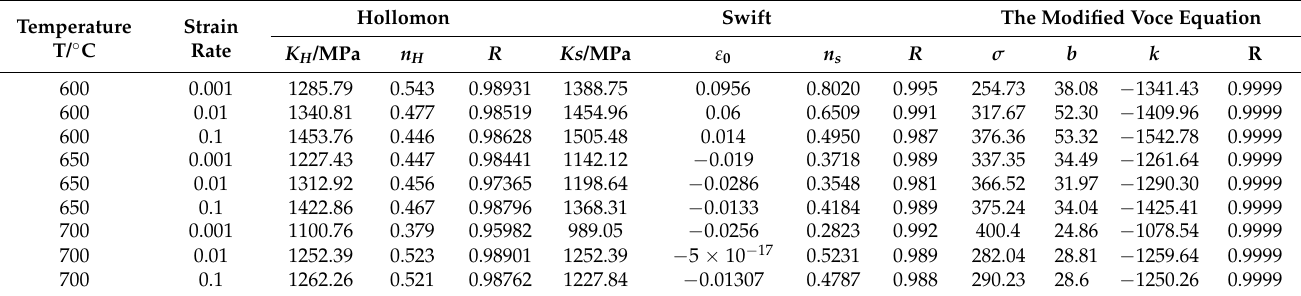
Table 5. Constitutive parameters in Hollomon, Swift, and the modified Voce equations fitted to stress–strain points with full range fitting by using the original